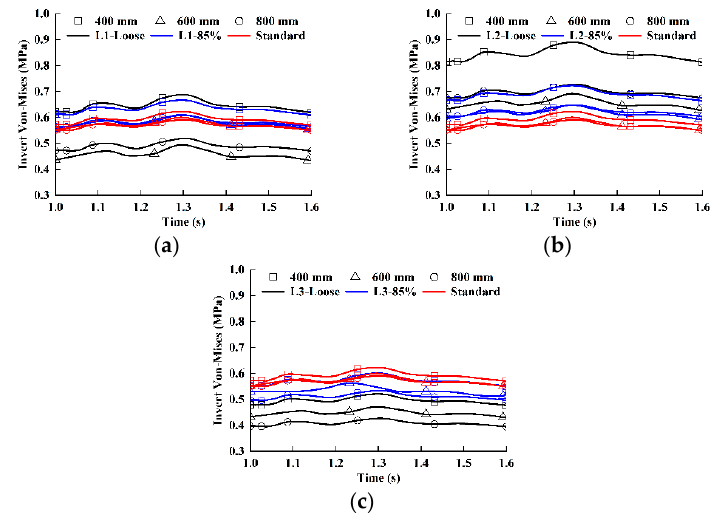
Figure 15. The invert Von-Mises stress of different diameter pipes under traffic load: ( a ) change in L1 compaction degree; ( b ) change in L2 compaction degree; ( c ) change in L3 compaction degree.